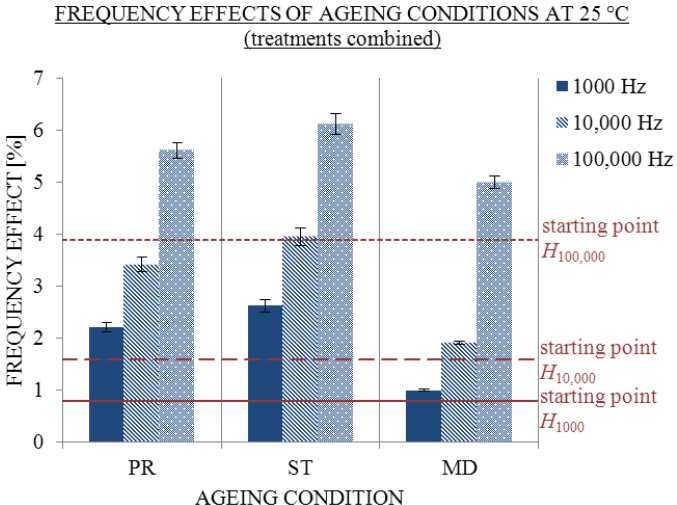
Figure 9. Influence of ageing condition on frequency effects H ; σ measured at 1000 (filled), 10,000 (striped) and 100,000 Hz (dotted) 25 °C with SE intervals, when the treatments are combined. Conductivity was measured initially (starting point H ) and on 310th day under PR, ST and MD conditions; number of replicate solutions, N (/): PR (28), ST (20), MD